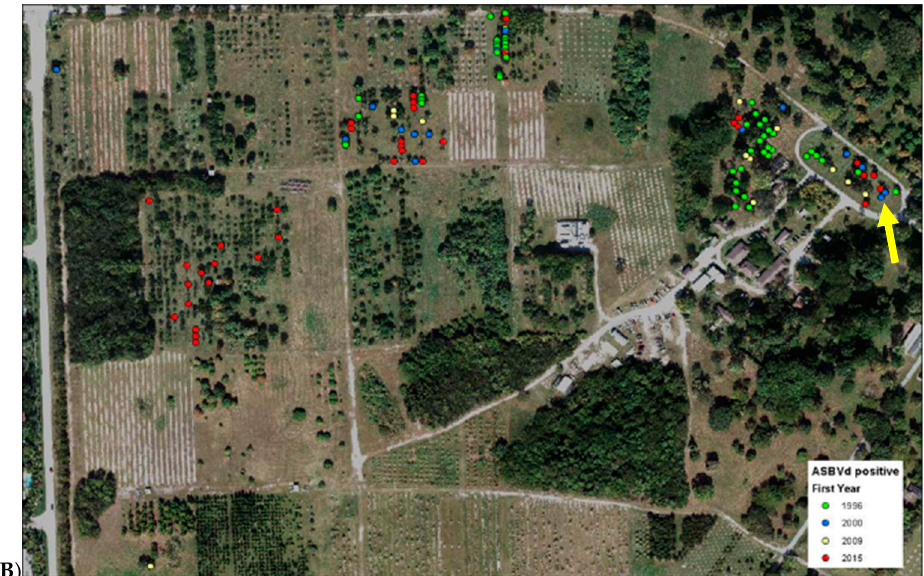
Figure 2. ( A ) Location of all avocado trees on the SHRS station and ( B ) location and first detection of ASBVd positive avocado trees on the SHRS station. Yellow arrow points to “Avocado Circle”.